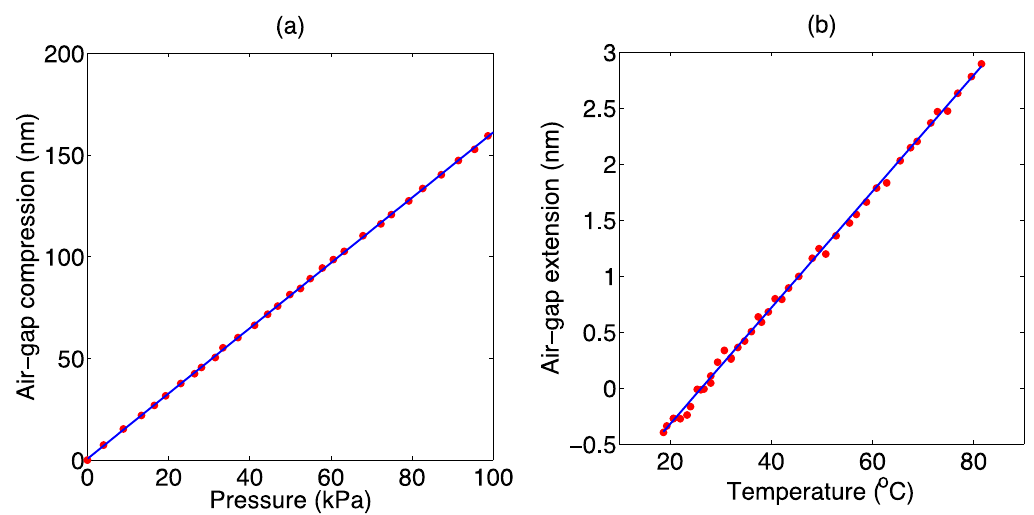
Figure 2. EFPI probe calibration. ( a ) Pressure calibration, reporting the Fabry-Perot cavity compression as a function of pressure, applied in an air tank at constant temperature; ( b ) Temperature calibration, reporting the cavity expansion factor as a function of applied temperature, in a thermal chamber, with no pressure variation.